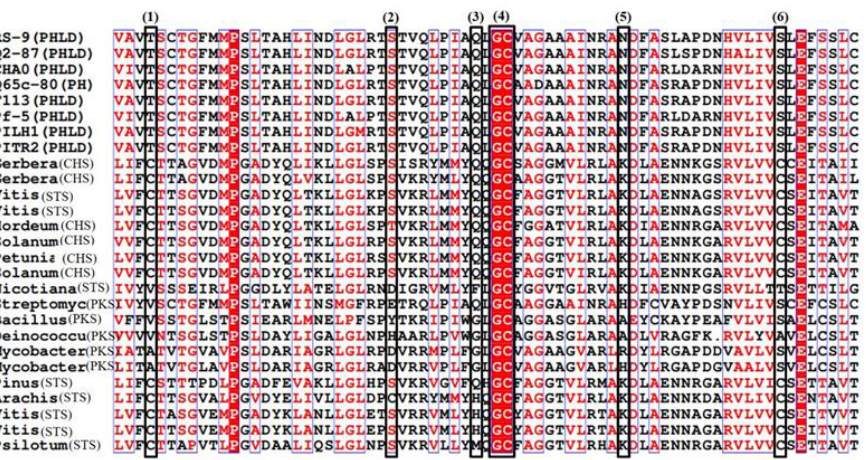
Figure 7. Alignment of predicted amino acid sequences for PHLD from various strains of Pseudo- monas and type III polyketide synthase (PKS) from Gram-positive bacteria and plant chalcone syn- thases/Stilbene synthase (CHS/STS). Conserved residues are indicated by boxes. (1) Cysteine (C135) from plant CHS implicated in substrate specificity and corresponding to threonine (T104) in PHLD. (2) Serine (S158) subunit contact site corresponding to S127 in PHLD. (3) Glutamine (Q166) residue conserved in most plant CHSs and corresponding to Q166 in the PKS of Streptomyces griseus and Q135 in PHLD proteins. (4) The glycine cysteine (GC) box corresponds to the conserved region with its catalytic cysteine residue. (5) Lysine (K180) residue, which corresponds to asparagine (N149) in PHLD, conserved strictly in the plant. (6) C195 involved in the product specificity in the plant